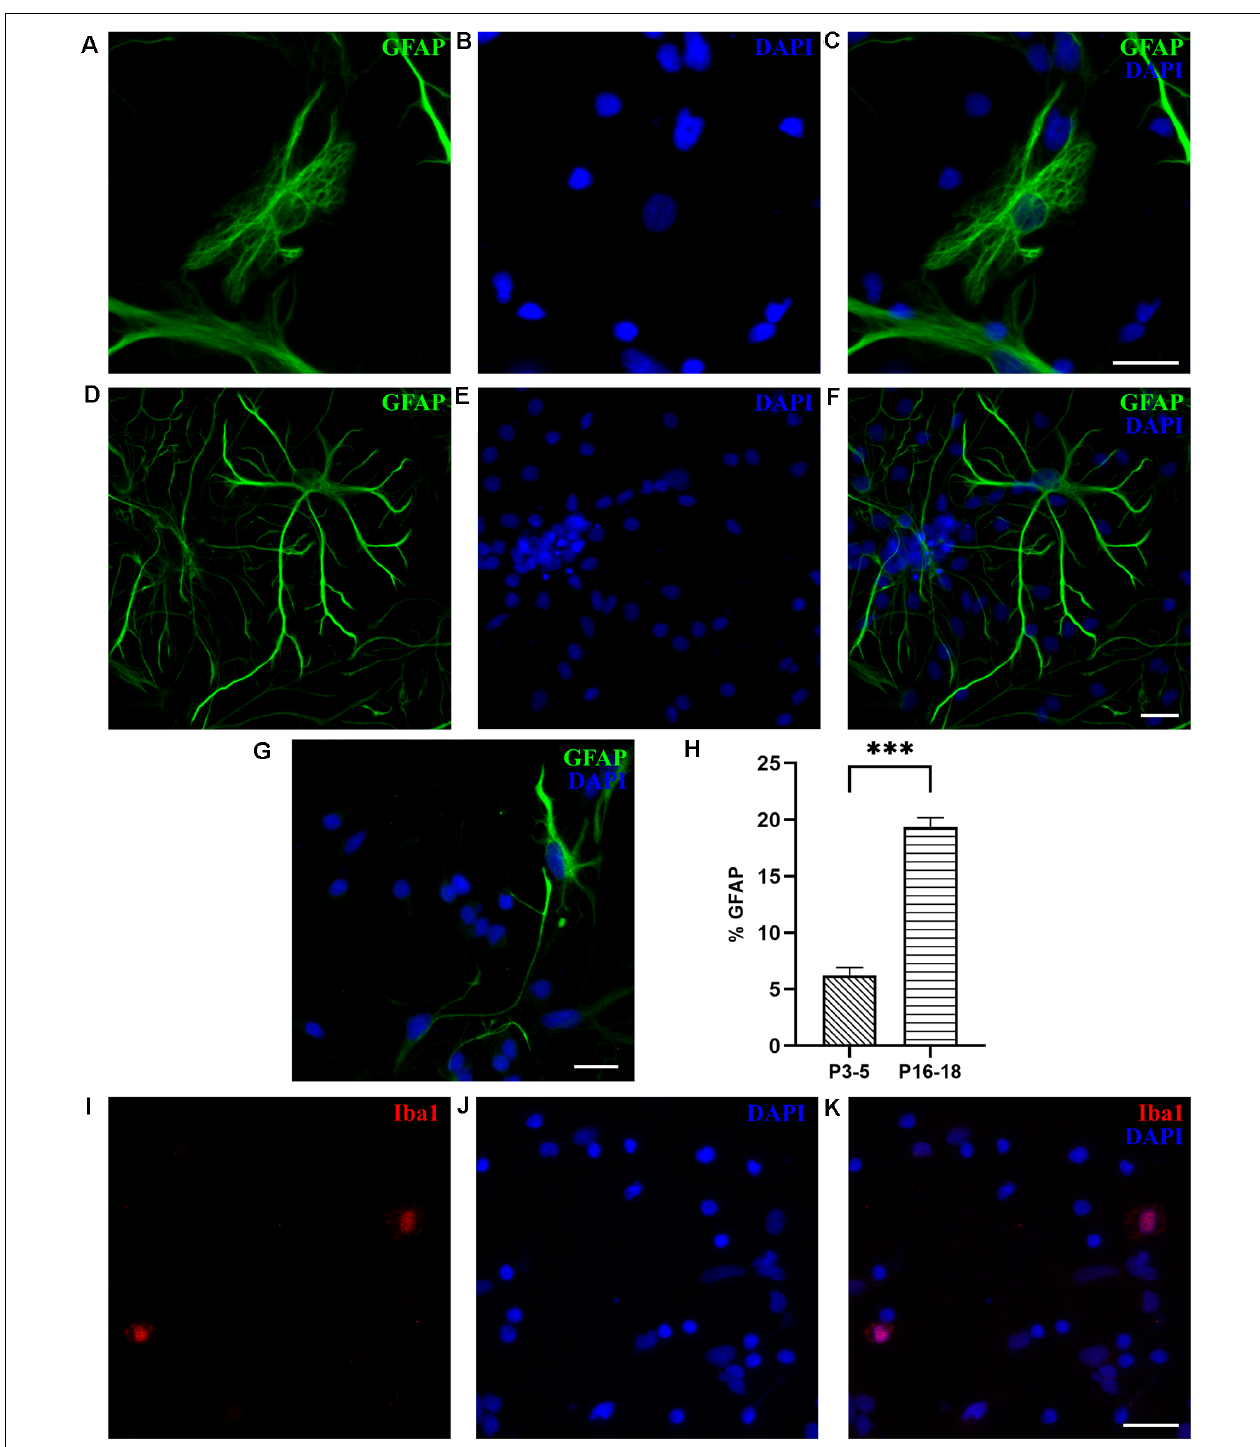
FIGURE 6 | Glial cells in cortical cultures prepared from P16 to P18 opossums. (A) Astrocytes at DIV7 primary cultures derived from the P17 cortex with protoplasmic-like morphology were stained for glial fibrillary acidic protein (GFAP, green). (B) Cell nuclei were stained with DAPI (blue). (C) Merged images of panels (A,B) . (D–F) Same as panels (A–C) showing astrocytes with stellate morphology. (G) DIV7 primary astrocytes derived from the P4 cortex and stained for GFAP (green) and DAPI (blue). (H) Histogram showing percentage of GFAP-positive cells among total cells, stained with DAPI, from primary cultures derived from different postnatal ages (P3–5 and P16–18, respectively). Unpaired t -test. P3–5 vs. P16–18 p < 0.001 ∗∗∗ . (I) Microglia in cortical cultures derived from P18 opossum, fixed at DIV1 and immunostained for microglial marker Iba1 (red). (J) DAPI nuclear stain and (K) merged image. Scale bar, 25 µ m.